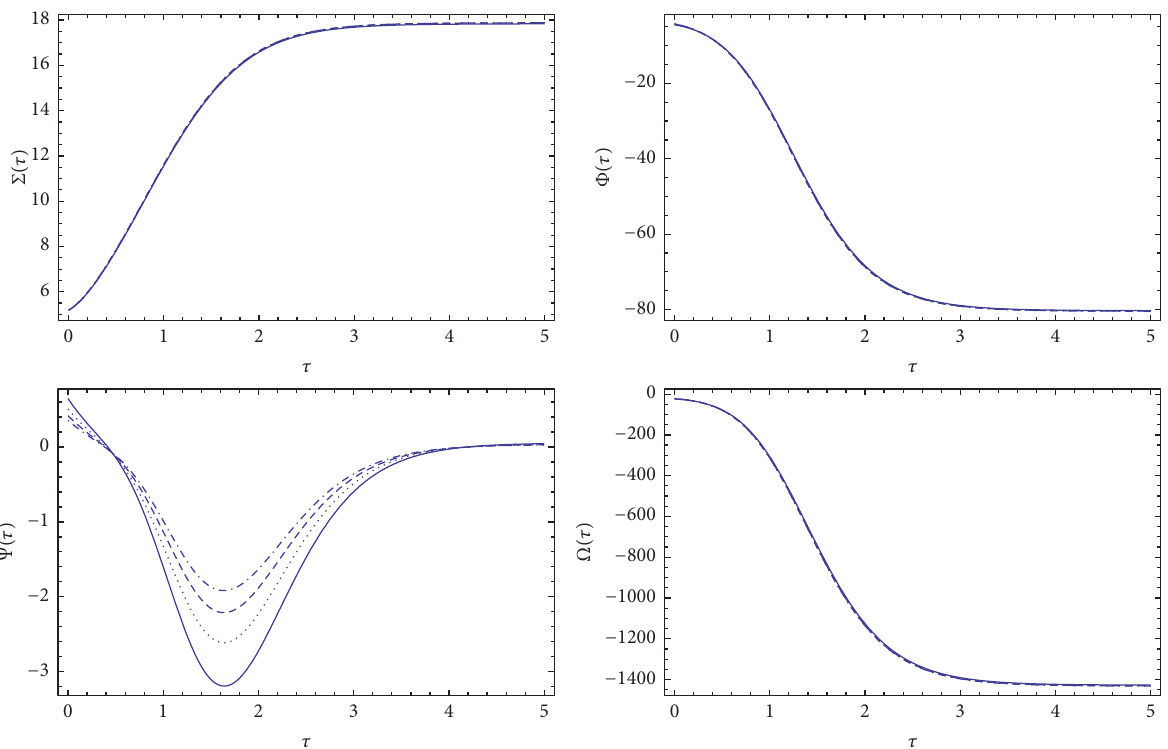
Figure 12: Time variation of the quantities (Σ,Φ,Ψ,Ω) , giving the Jacobi stability of the phantom quintessence field cosmological model with power law potential for different values of 𝛼 : 𝛼 = 0.8 (solid curve), 𝛼 = 1 (dotted curve), 𝛼 = 1.2 (dashed curve), and 𝛼 = 1.4 (dashed dotted curve),